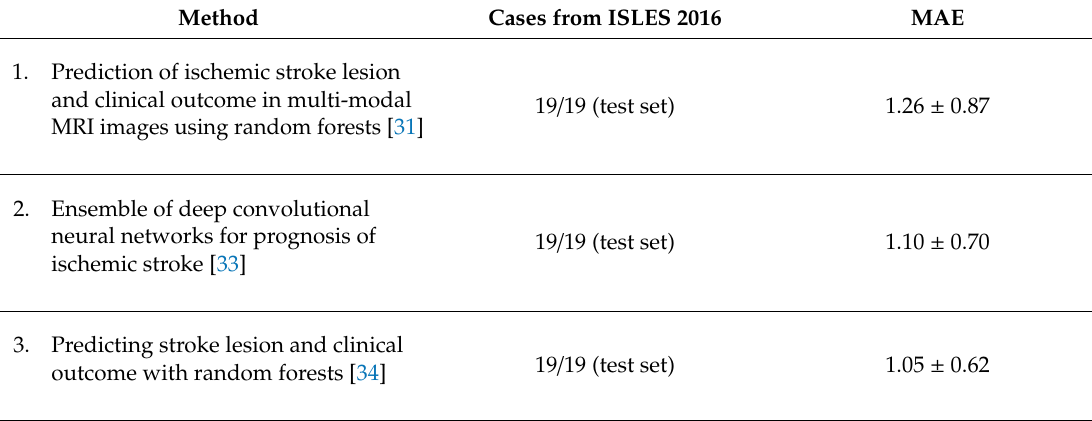
Table 7. ISLES 2016 challenge result showing the state-of-the-art method as top result [12].